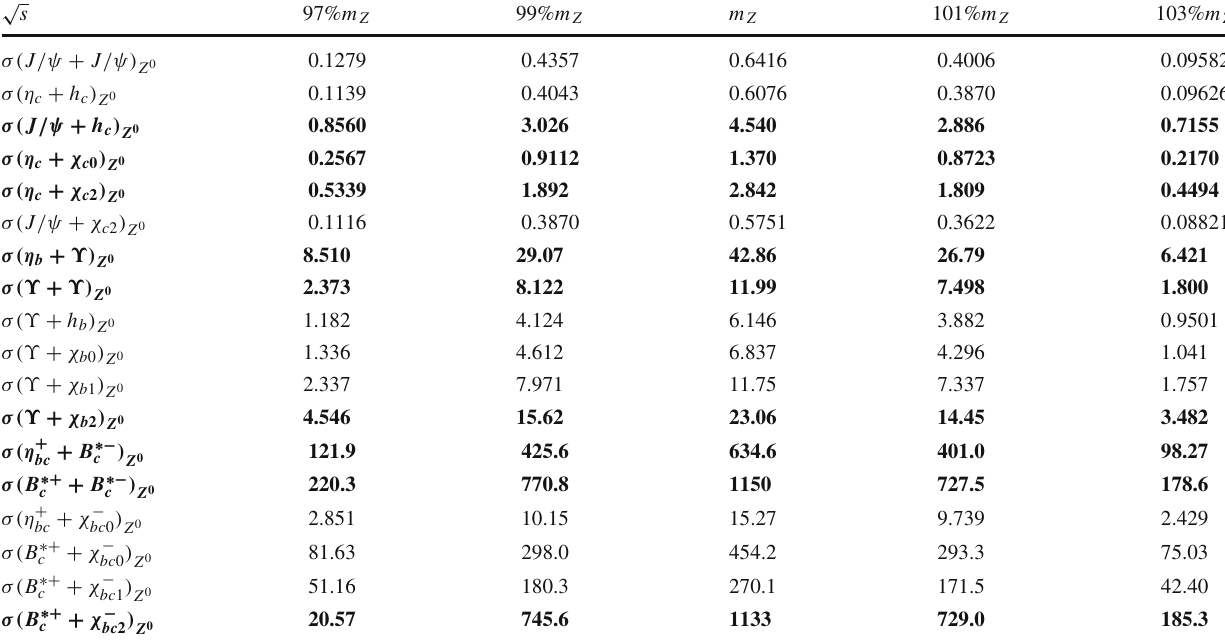
Table 3 The deviations of cross sections (units: × 10 − 3 fb) for the top six channels for the production of double charmonia, double bottomonia, √ s deviates from the Z 0 mass pole by 1% m Z and 3% m Z . The top three channels are in bold face and double B c mesons when the CM energy √